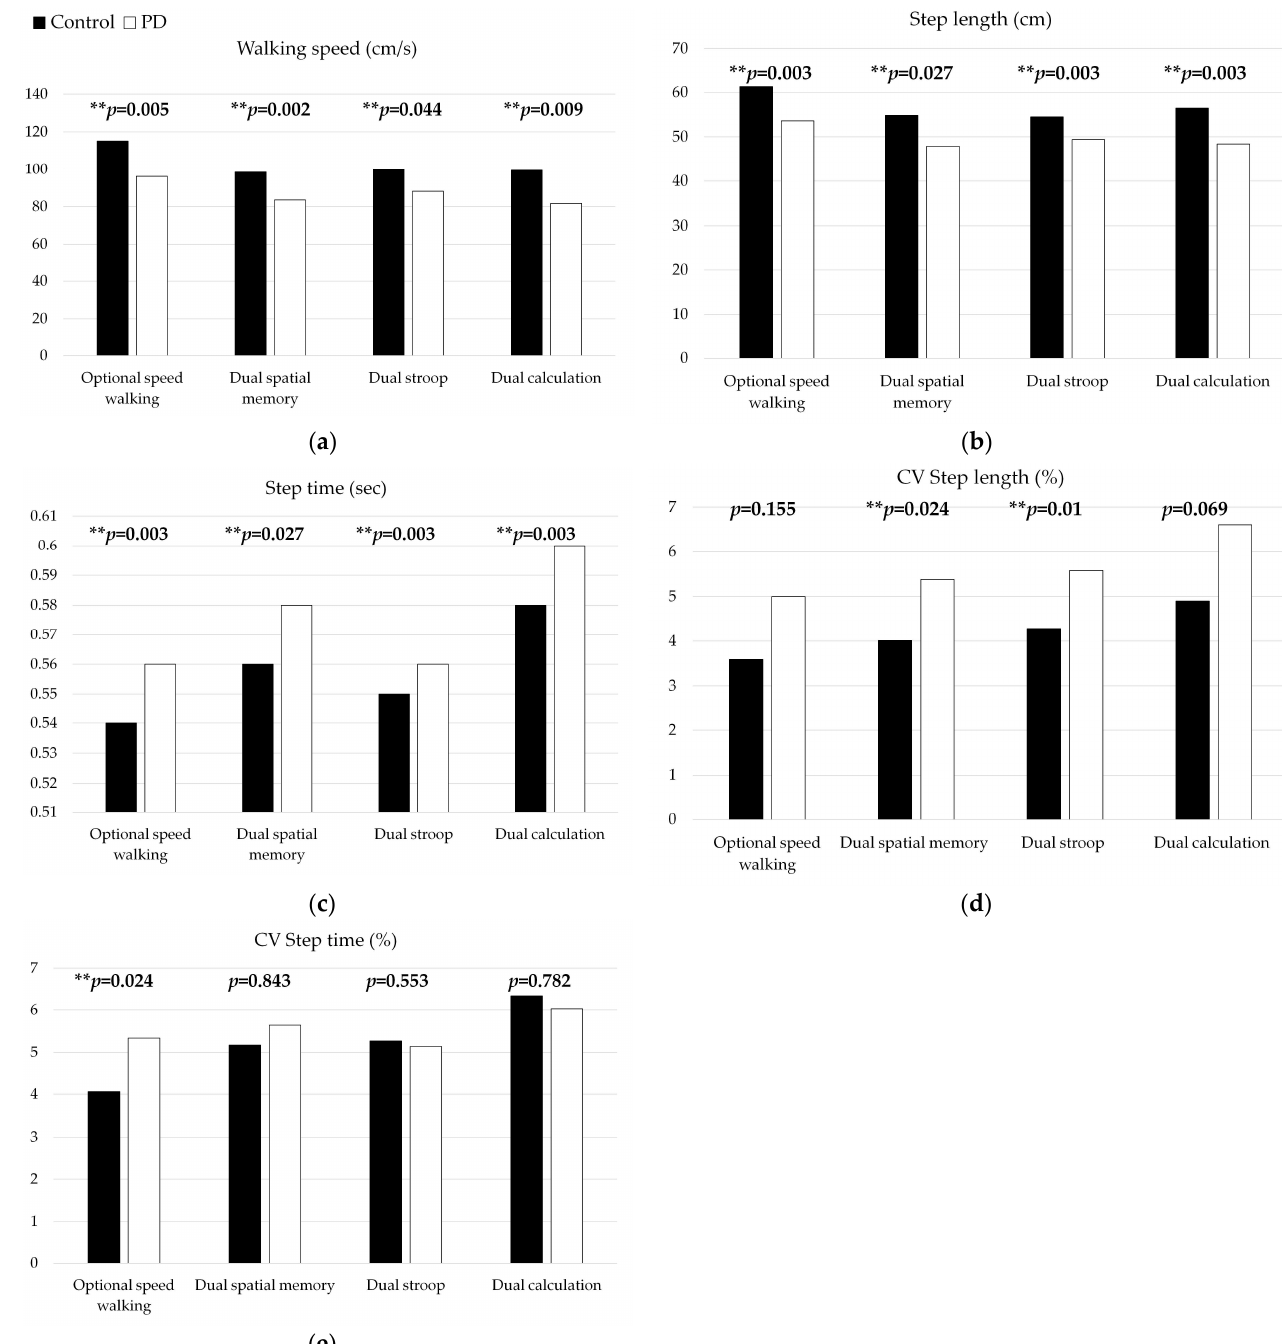
Figure 3. The walking performance includes ( a ) Walking speed, ( b ) Step length, ( c ) Step time, ( d ) CV Step length, and ( e ) CV Step time, under the group single and dual tasks between healthy and PD group. ** p <